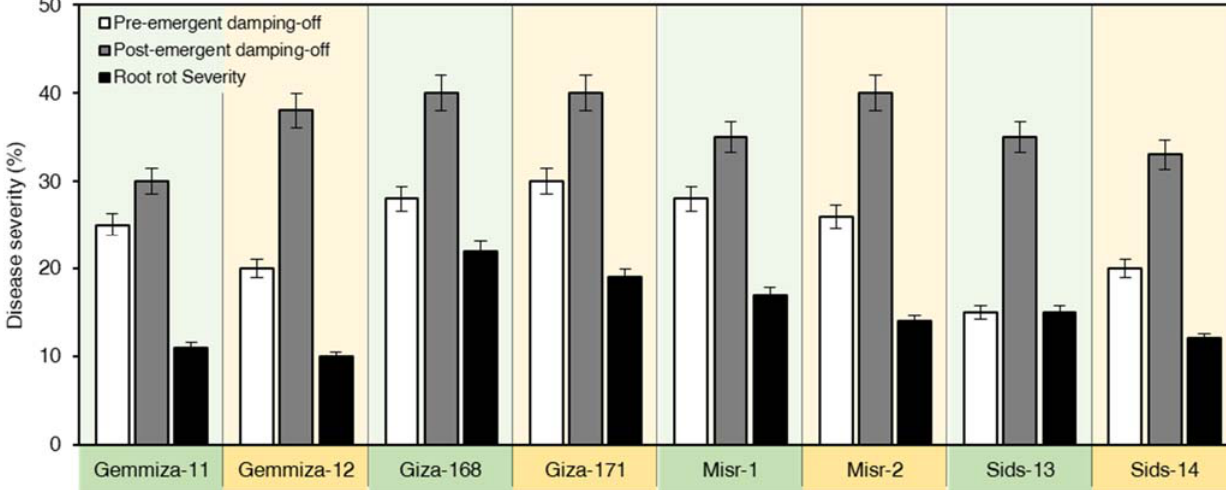
Figure 2. Pathogenicity of R. solani against eight Egyptian bread wheat cultivars. The experiment was repeated twice independently. Data presented are means ± standard deviation (mean ± SD) of five biological replicates.